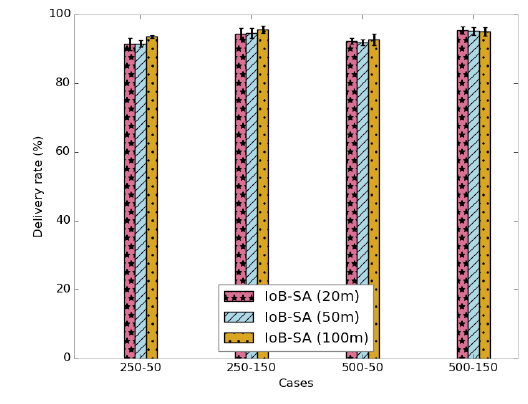
Figure 24. Average delivery rate for IoB-SA.